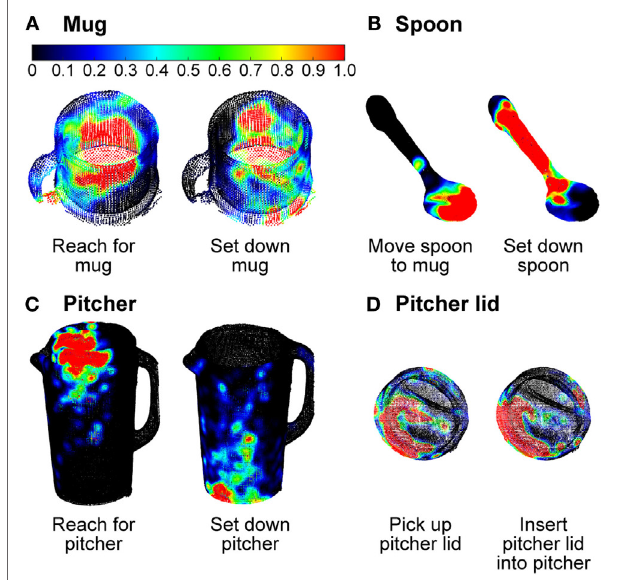
FigUre 11 | Three-dimensional gaze saliency maps of the task-related objects [mug (a) , spoon (B) , pitcher (c) , and pitcher lid (D) ] are shown for a subset of action units. The RGB color scale for all gaze saliency maps is shown in panel (a)